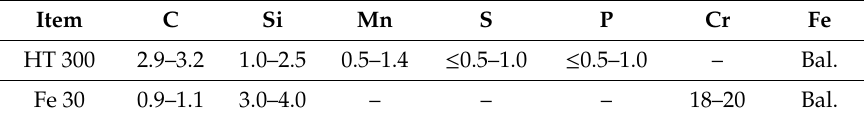
Table 1. Chemical composition of HT 300 and Fe-based alloy powder in